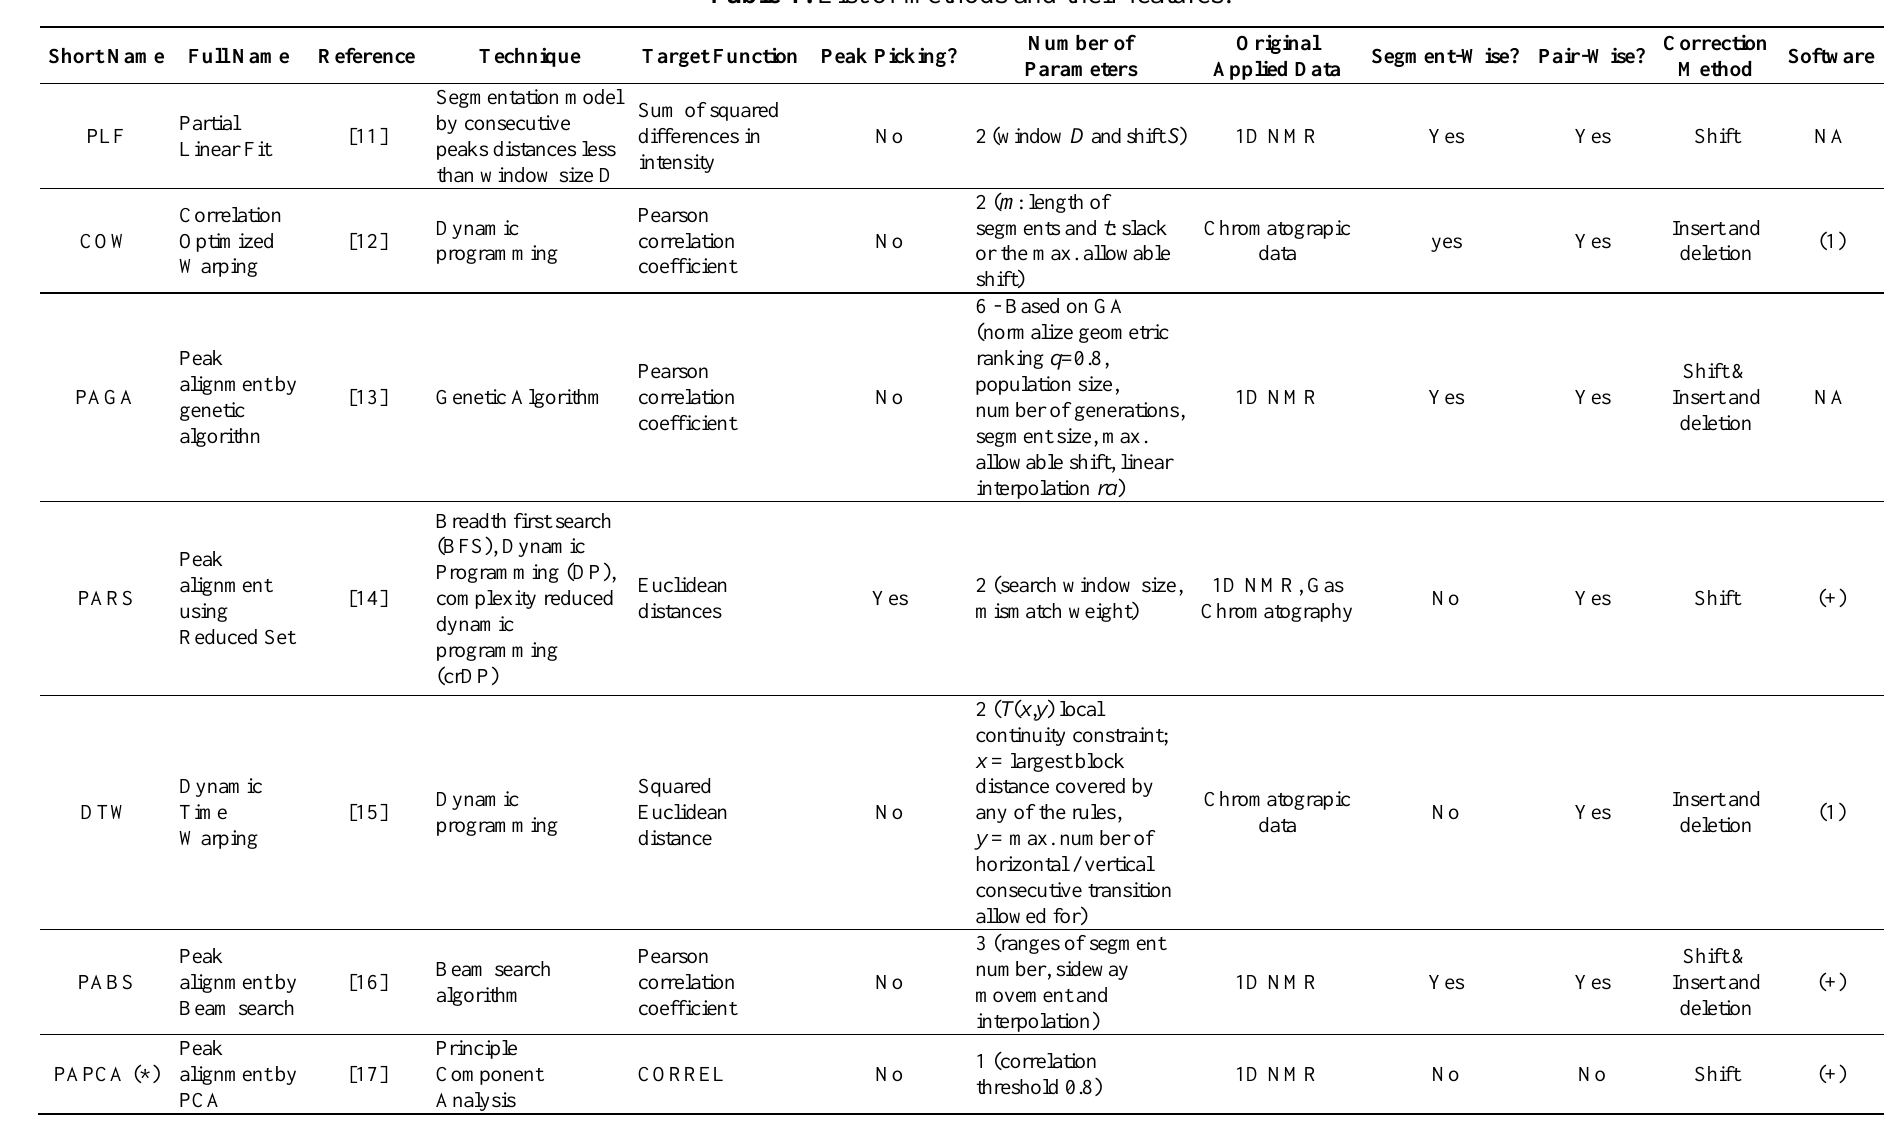
Table 1. List of methods and their